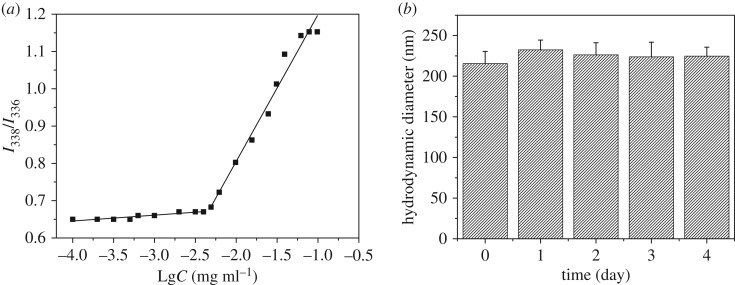
(a) Plot of intensity ratios (I338/I336) as function of logarithm of the copolymer DSPE-b-PEG-b-PAE-b-PEG-b-DSPE concentrations. (b) The serum stability of nanoparticles incubated in PBS solution with 20% FBS at pH of 7.4.